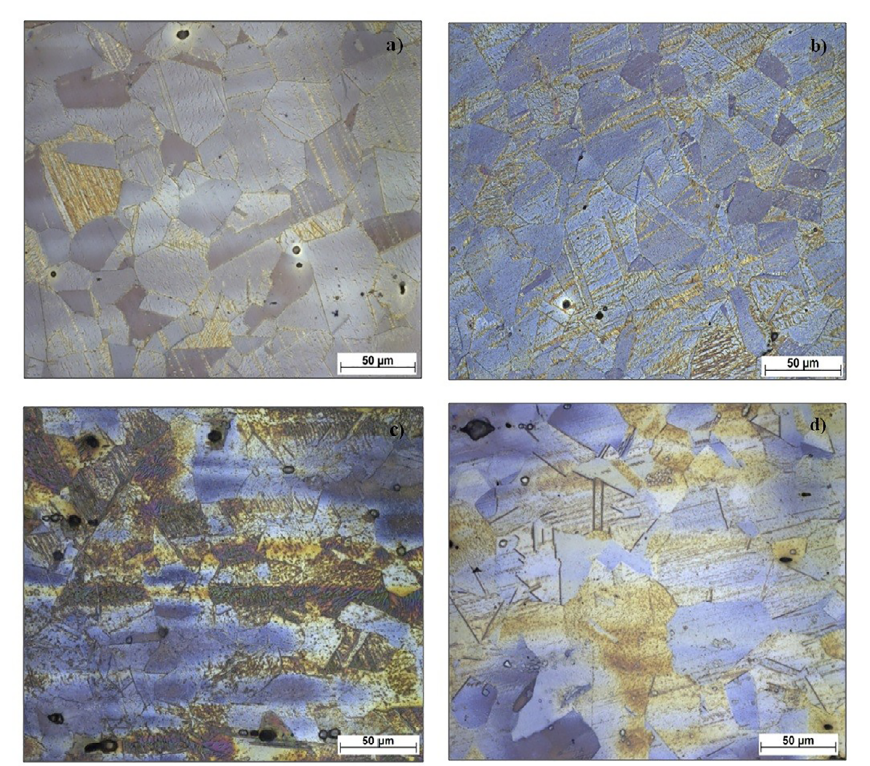
Figure 6. Microstructures of manganese steels: a) 20% manganese, b) 22% manganese, c) 26% manganese and d) 28% manganese. Source: author.